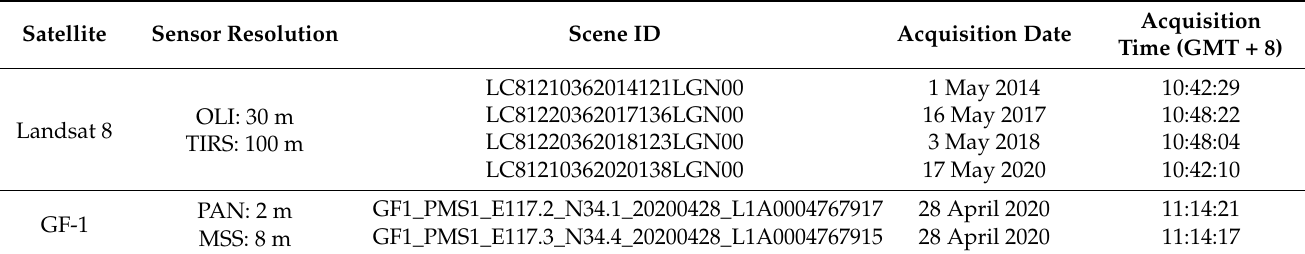
Table 1. Technical parameters of Landsat 8 and GF-1 data.